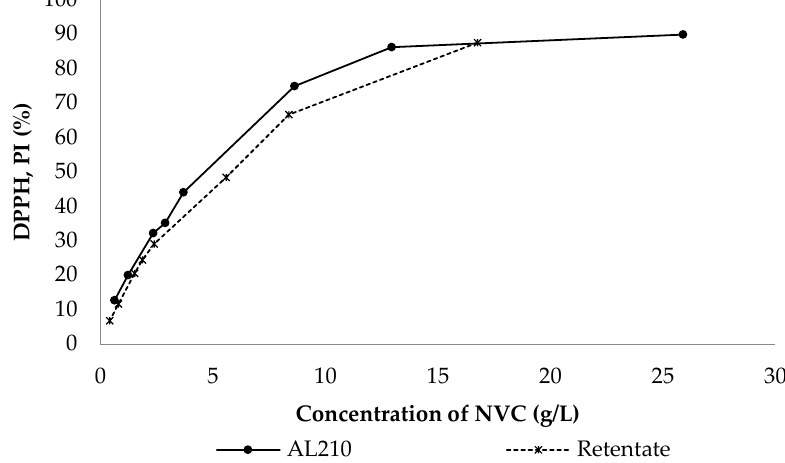
Figure 5. Effects of the concentration on the DPPH radical scavenging activity, expressed as percentage of inhibition, PI (%), for autohydrolysis liquors at 210 °C (AL210) and retentate.